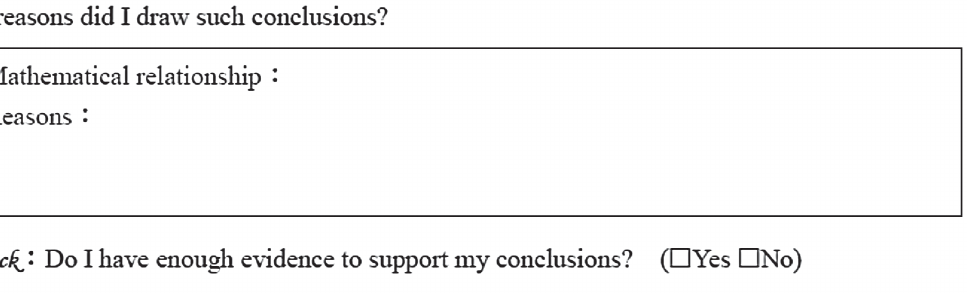
FIG. 5. An example of an inquiry worksheet and the metacognitive prompts used for